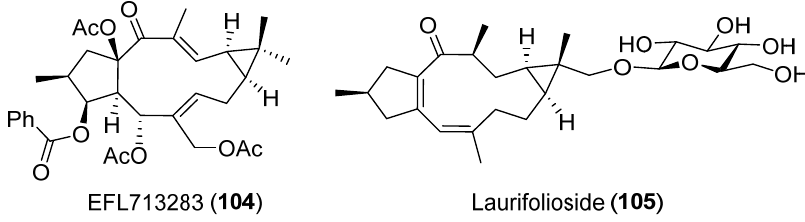
Figure 17. Structure of EFL713283 ( 104 ) and laurifolioside ( 105 ).